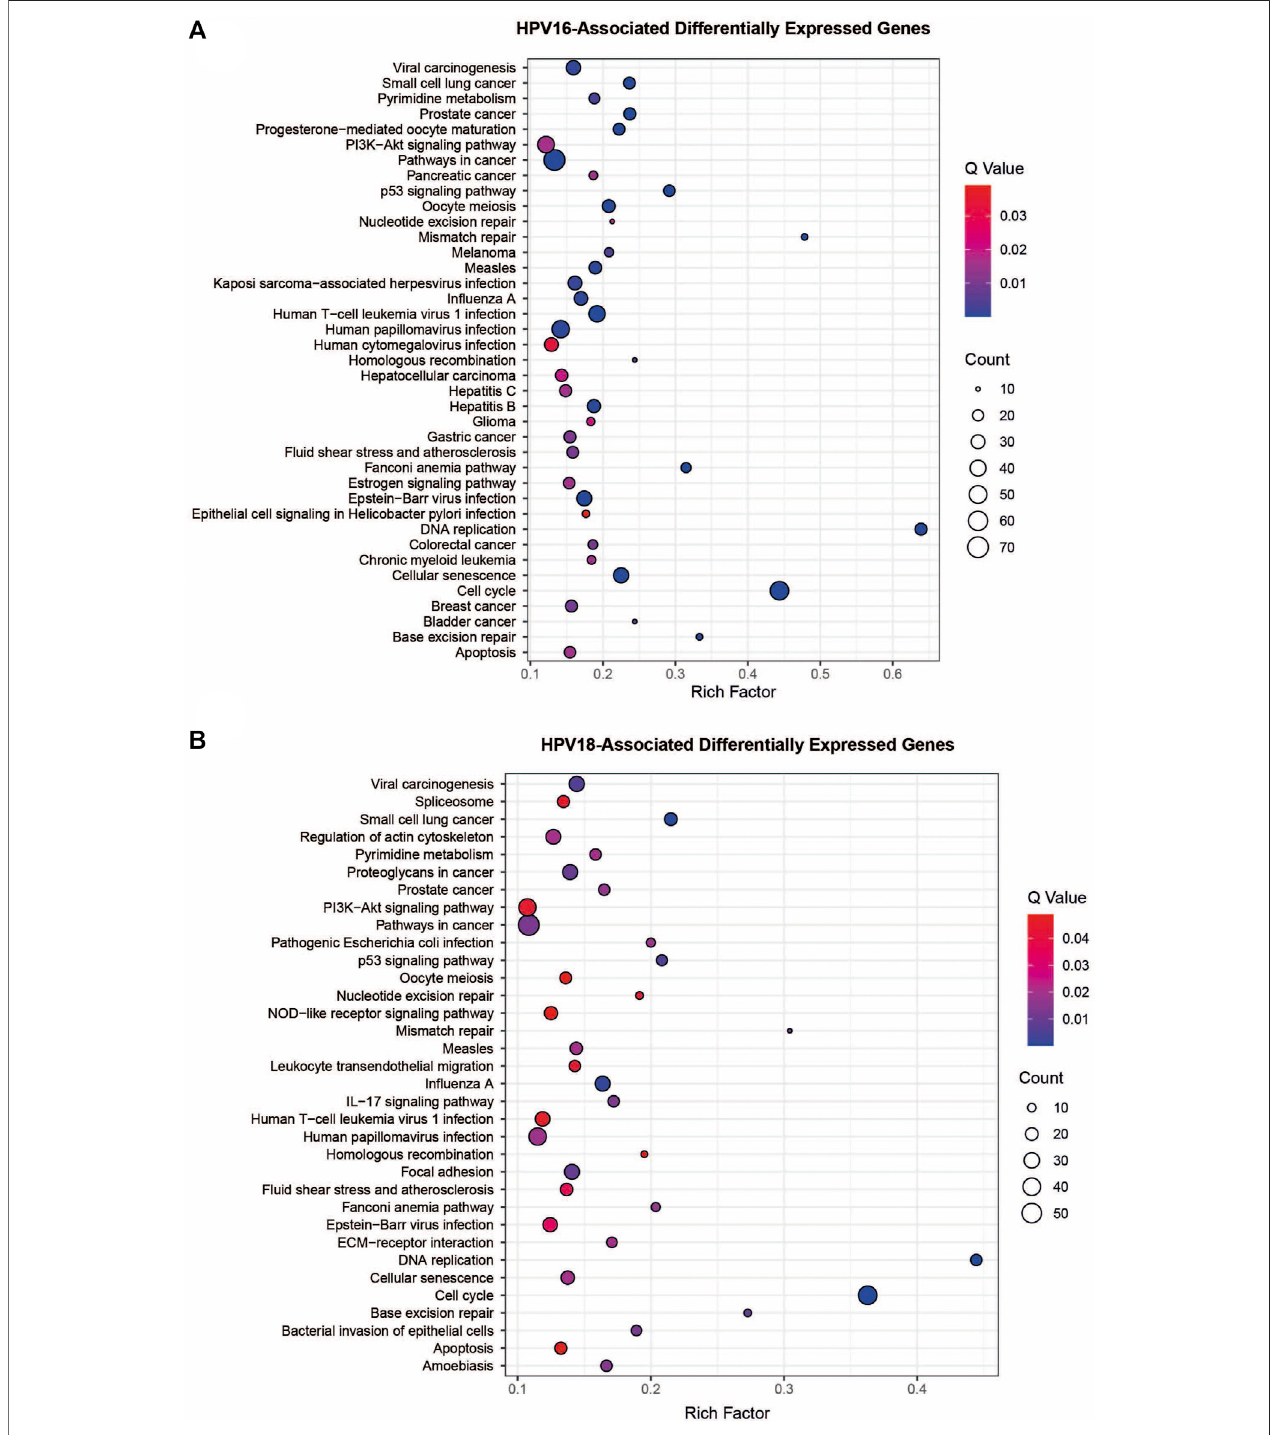
FIGURE 3 | The pathway overrepresentation analysis of HPV16- and HPV18-associated differentially expressed genes (DEGs). (A) A plot representing overrepresentation analysis of HPV16- associated DEGs. (B) A plot representing overrepresentation analysis of HPV18- associated DEGs.